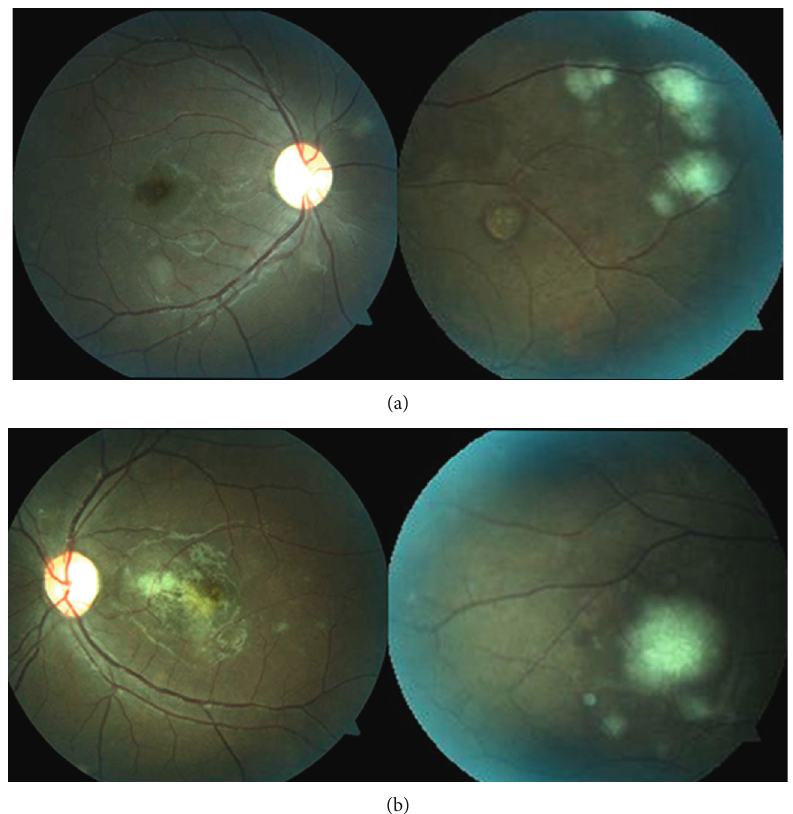
Figure 1: Fundus photograph of the (a) right and (b) left eyes displayed multiple yellowish subretinal lesions through the posterior pole and midperiphery in both eyes with a well-demarcated large deep macular lesion on the left